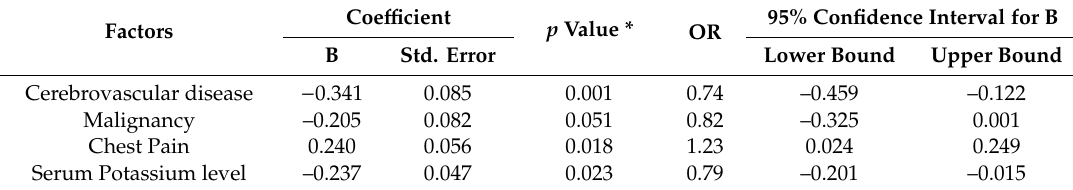
Table 4. Logistic regression coe ffi cients (beta) and odds ratio estimates from the multivariate logistic regression models for factors a ff ecting